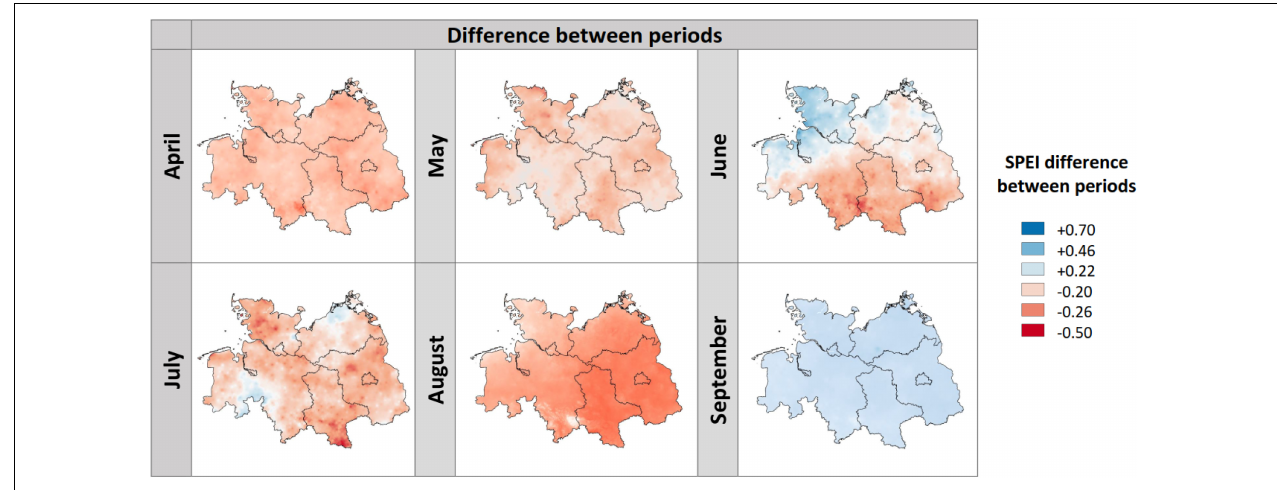
FIGURE 7 | Difference in mean monthly SPEI between the period average of 1948–1982 and of 1983–2017 for the six growing season months (April to September) in the study region. A SPEI decrease stands for climate aridification, an increase for a reduction in aridity.